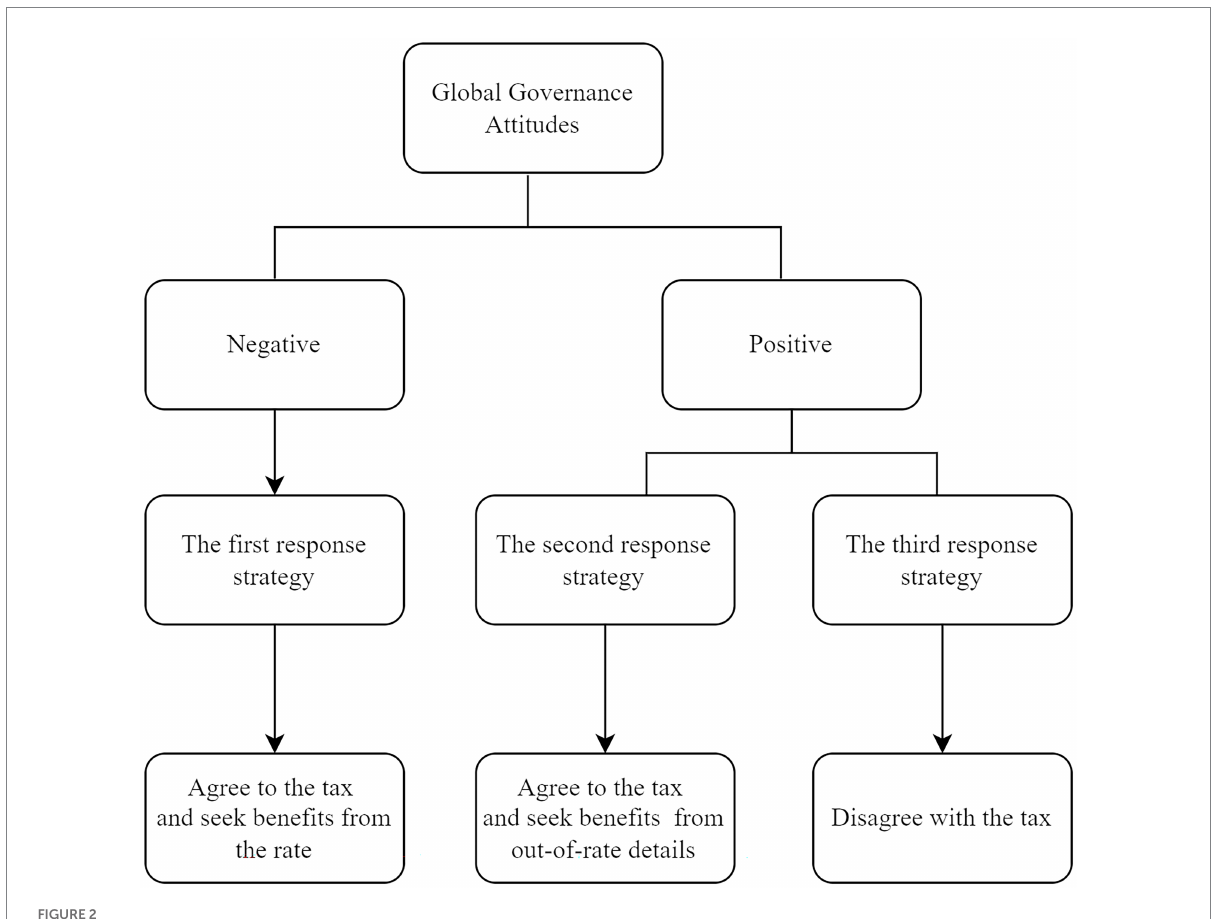
FIGURE 2 Three response strategies of the global minimum